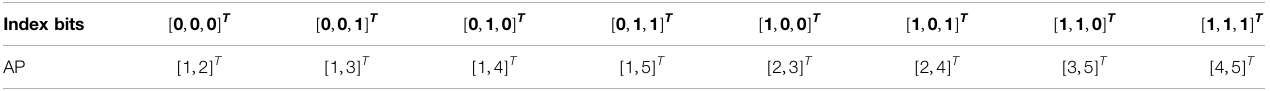
TABLE 2 | IM mapping example with N (cid:1) 5 , N a (cid:1) 2, and B 4 (cid:1) 3.